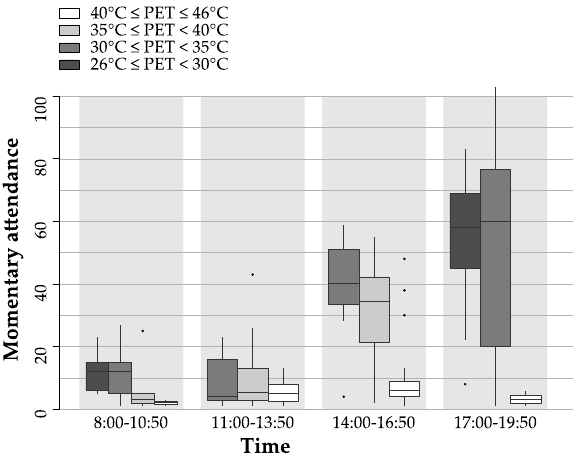
Figure 4. Attendance for classes of PET for four-time intervals during the day: morning (8:00, 10:50), midday (11:00, 13:50), afternoon (14:00, 16:50), late afternoon (17:00, 19:50) in San Silvestro Square [3].